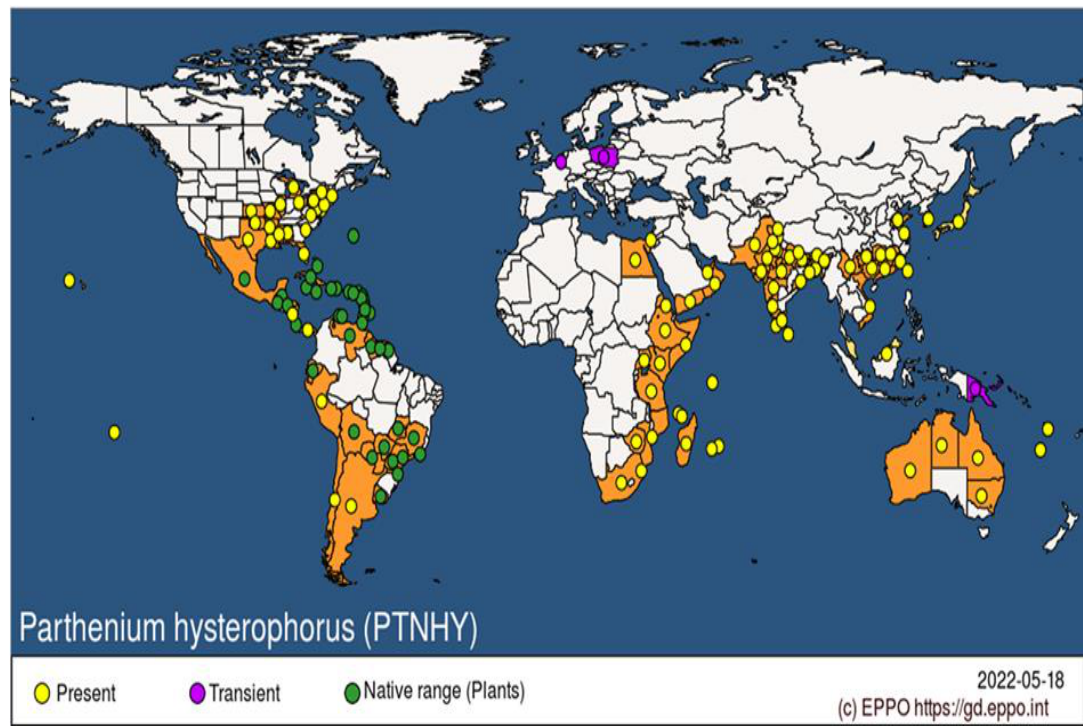
Figure 1. Worldwide distribution of Parthenium hysterophorus L. (Source; EPPO https://gd.eppo.int/taxon/PTNHY/distribution; accessed on 29 September 2022).